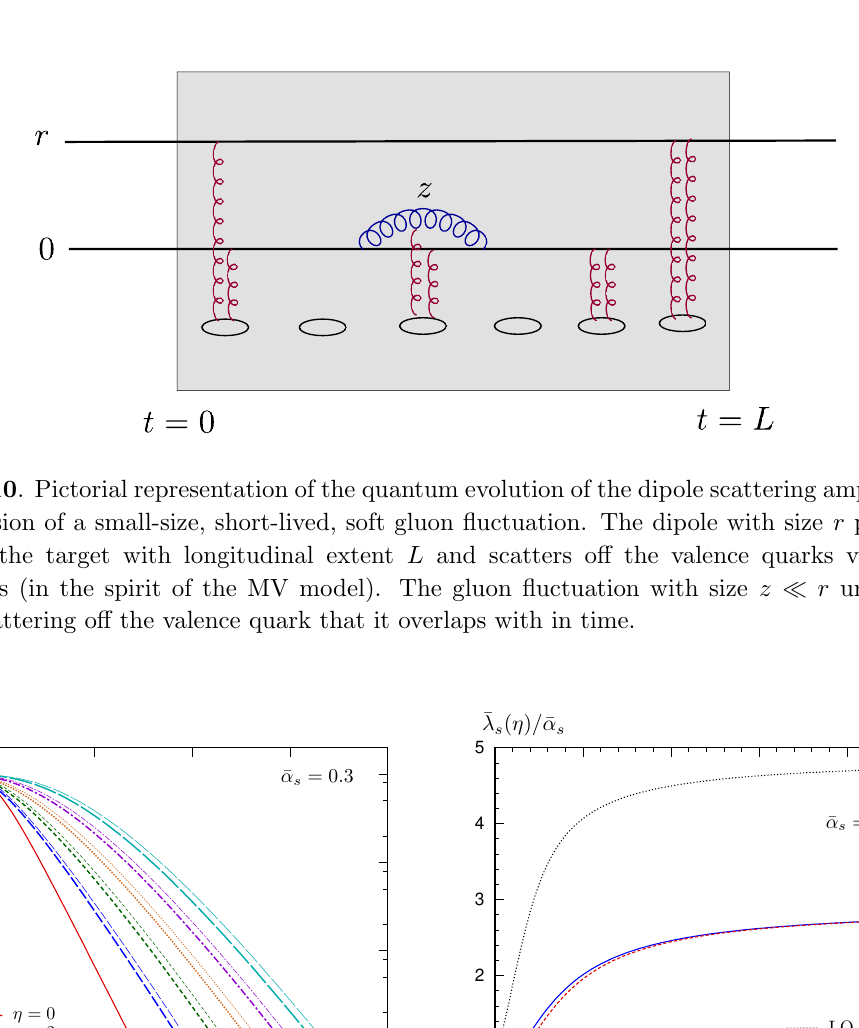
Figure 11 . Comparing the numerical solutions to the \canonical" non-local equation (6.1) (the same as (9.1) with (cid:17) 0 = 0) and the new eq. (9.3), for (cid:22) (cid:11) s = 0 : 3. Left: the respective predictions for the dipole amplitude: thick lines correspond to eq. (9.3) and thin lines to eq. (6.1). Right: the speed of the fronts as a function of (cid:17) ; for illustration, we also show the respective prediction of the LO BK